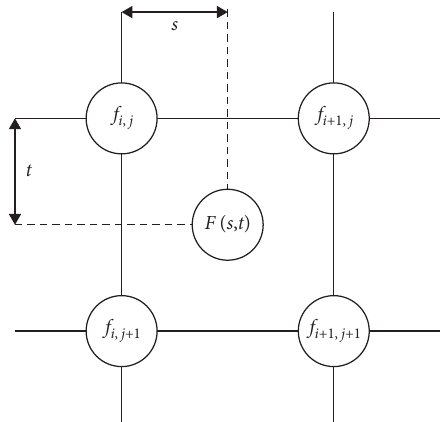
Figure 1: Flowchart of the proposed method.